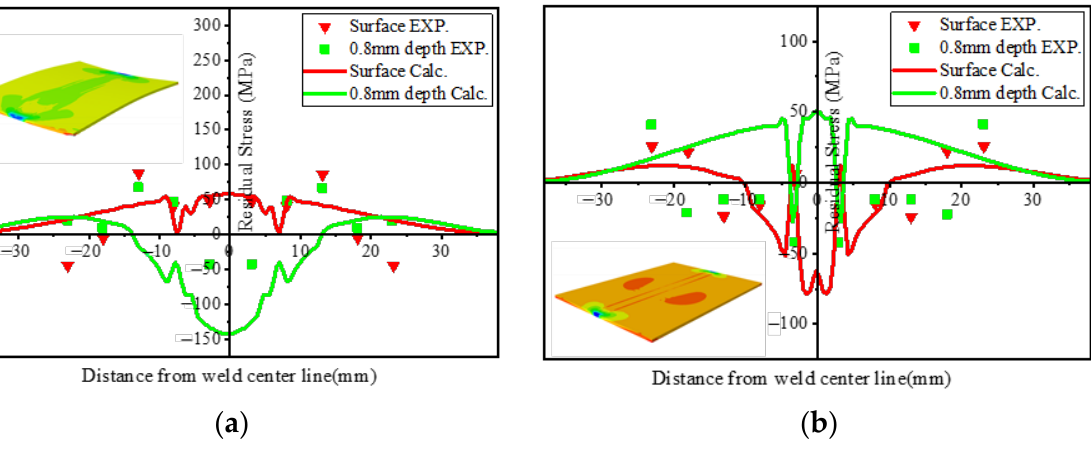
Figure 26. Transverse residual stress distribution at different depths: ( a ) TIG weldment, ( b ) LBW weldment. Solid phase transformation mainly occurs in the FZ and HAZ zone, which changes the phase composition and phase proportion of the weld seam. Due to the different thermal expansion coefficients and different unit lattice volumes of each phase, solid phase transfor- mation affects the local expansion and contraction of the weld seam and then changes the distribution of tensile and compressive stress in the local of the weld seam, but the solid phase transformation has little effect on the overall distribution trend of residual